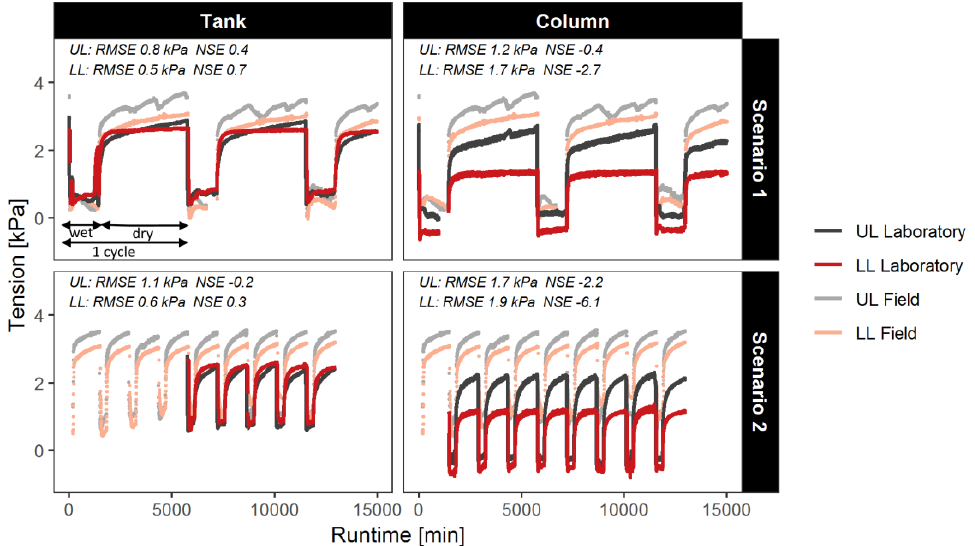
Figure 2. Tension measurements of laboratory experiments (tank and column) compared to field measurements in 0.3 m (UL—upper layer) and 0.7 m (LL—lower layer) depths for scenarios 1 and 2. Column values always range below those of the tank and FIU values. They also show the largest difference between tension values of the upper and the lower layer. This is contrary to the tank experiment, where tension values in the upper and lower layer are similarly high. In the FIU, a small yet distinct difference between values of the upper and the lower layer can be observed. The wetting phase of the FIU experiments can be reproduced reasonably well by the tank experiment. Here, tank and FIU values range around 0.7 kPa, whereas column values rank distinctively lower around zero kPa.